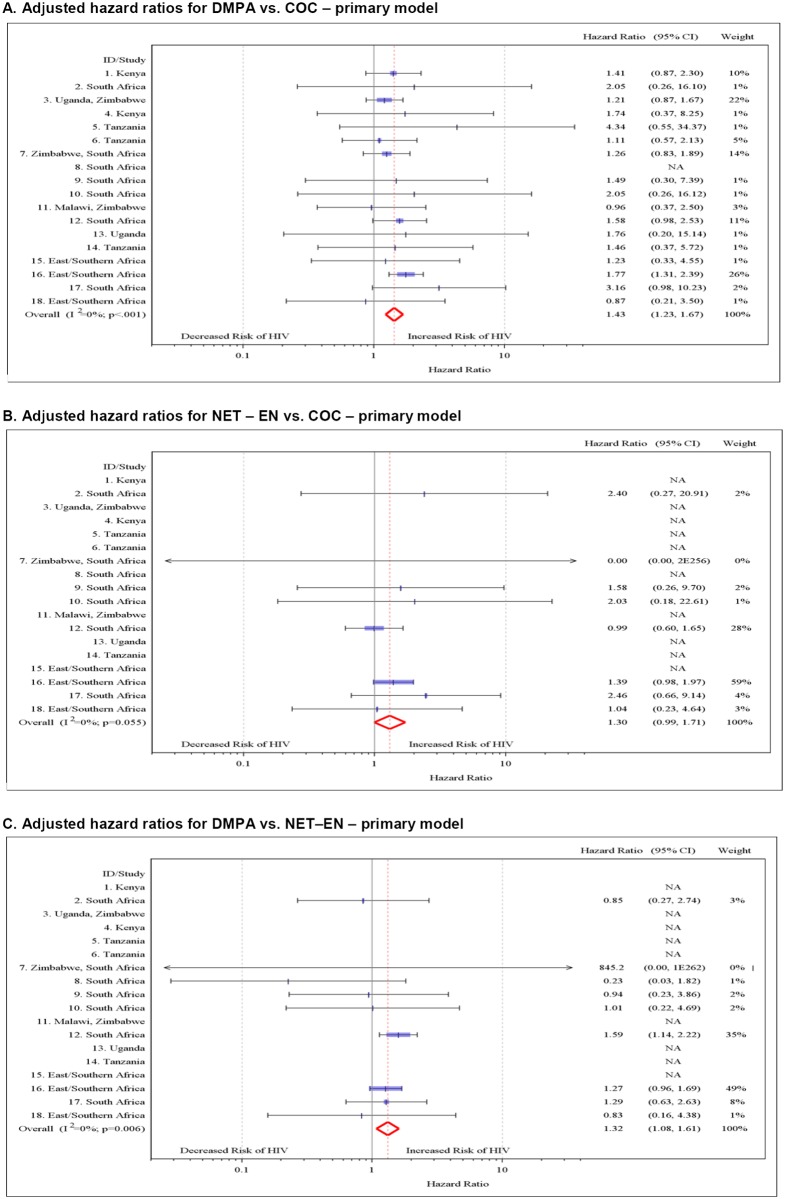
Multivariable associations directly comparing different hormonal contraceptives and HIV acquisition by study.(A) aHRs for DMPA versus COC use—primary model. (B) aHRs for NET-EN versus COC use—primary model. (C) aHRs for DMPA versus NET-EN use—primary model. Individual study results from Cox regression modeling. Pooled aHRs from random effects meta-analysis adjusted for age, married/living with partner, number of sex partners, condom use, and region (east Africa, southern Africa, and South Africa). Each horizontal line represents the 95% confidence interval around the HR. Shaded areas represent the comparative weight of each study. No estimate was possible if there were not events in the specified contraceptive group.